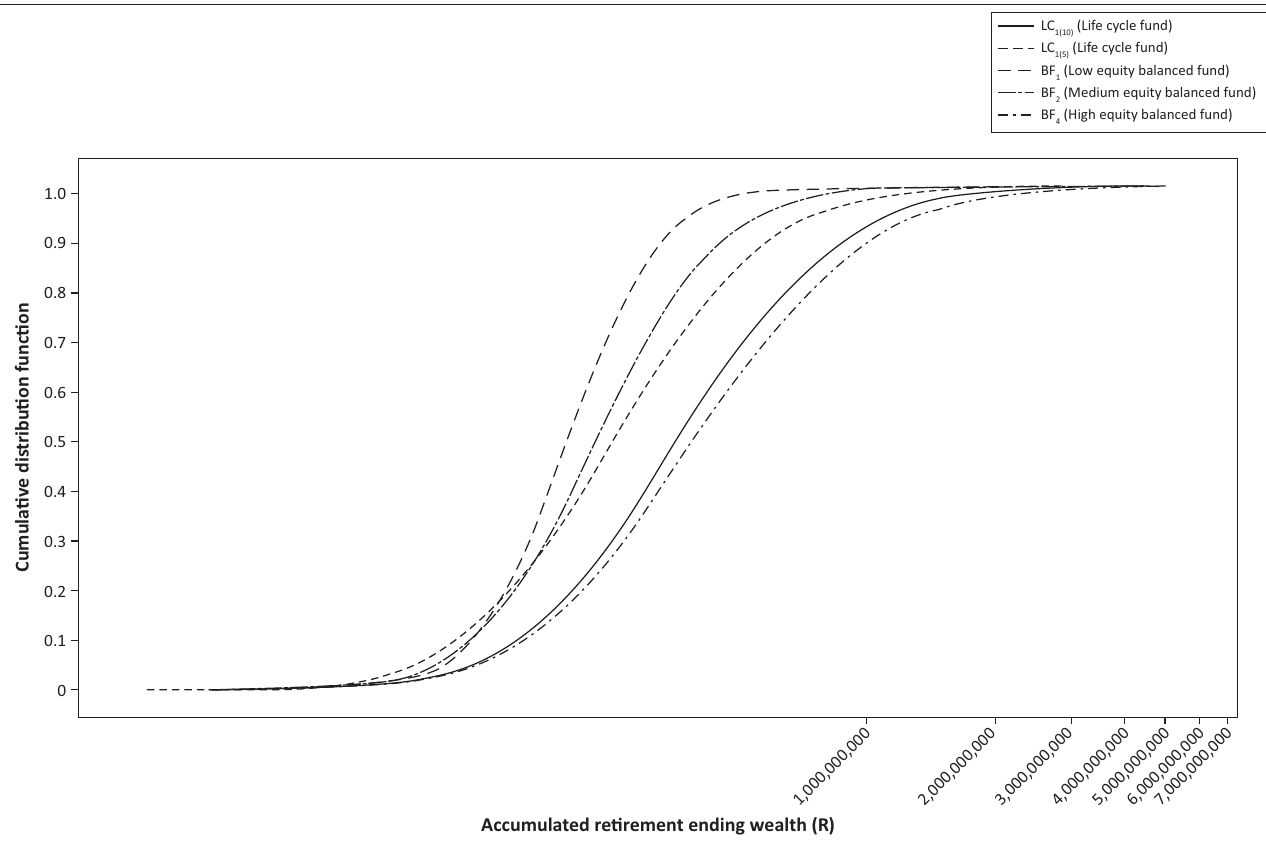
FIGURE 3: Cumulative distribution functions of accumulated retirement ending wealth for models LC